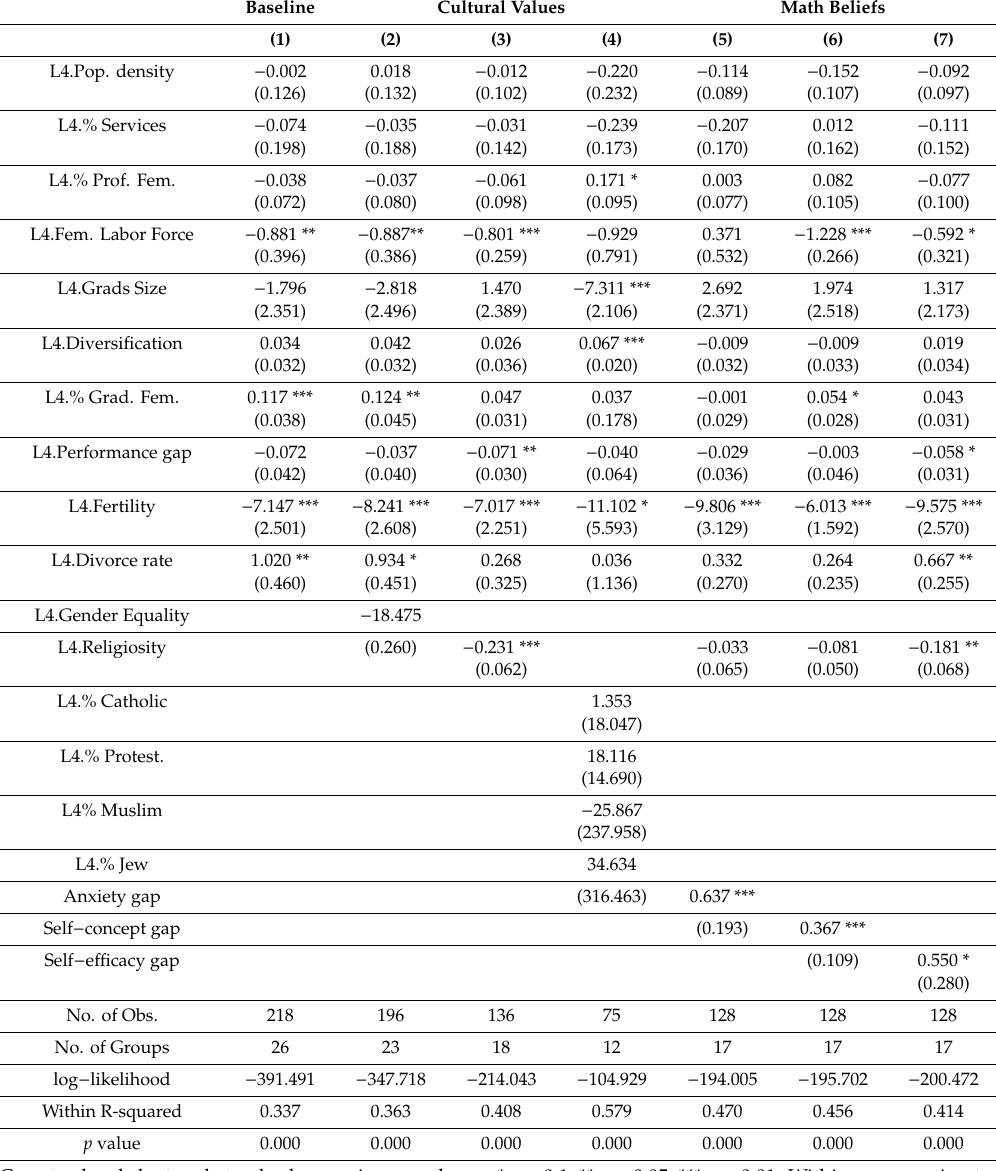
Table 1. Country-level Gender Segregation. Dependent variable: Dissimilarity index (1